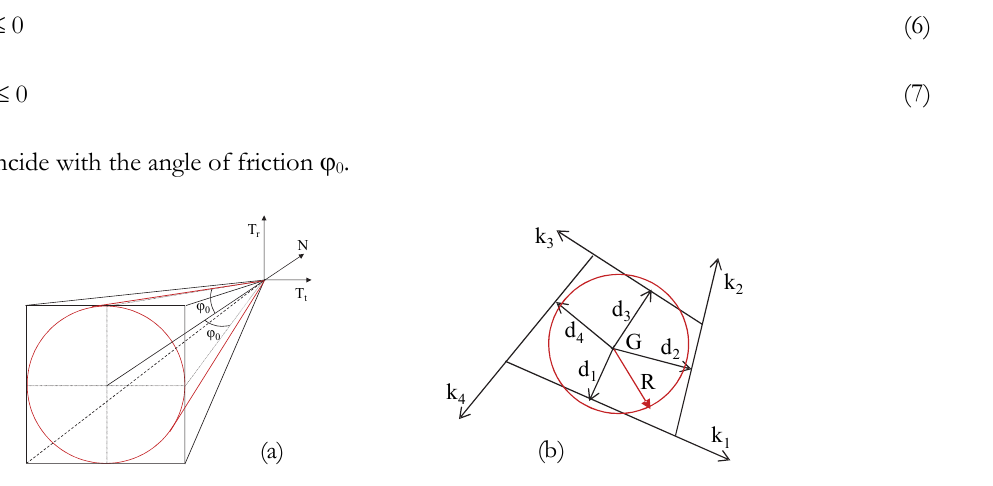
Figure 11: Yield domain for sliding. (a) Yield domain normal force N - shear force T ; (b) Yield domain normal force N - twisting moment M n , "equivalent" circular